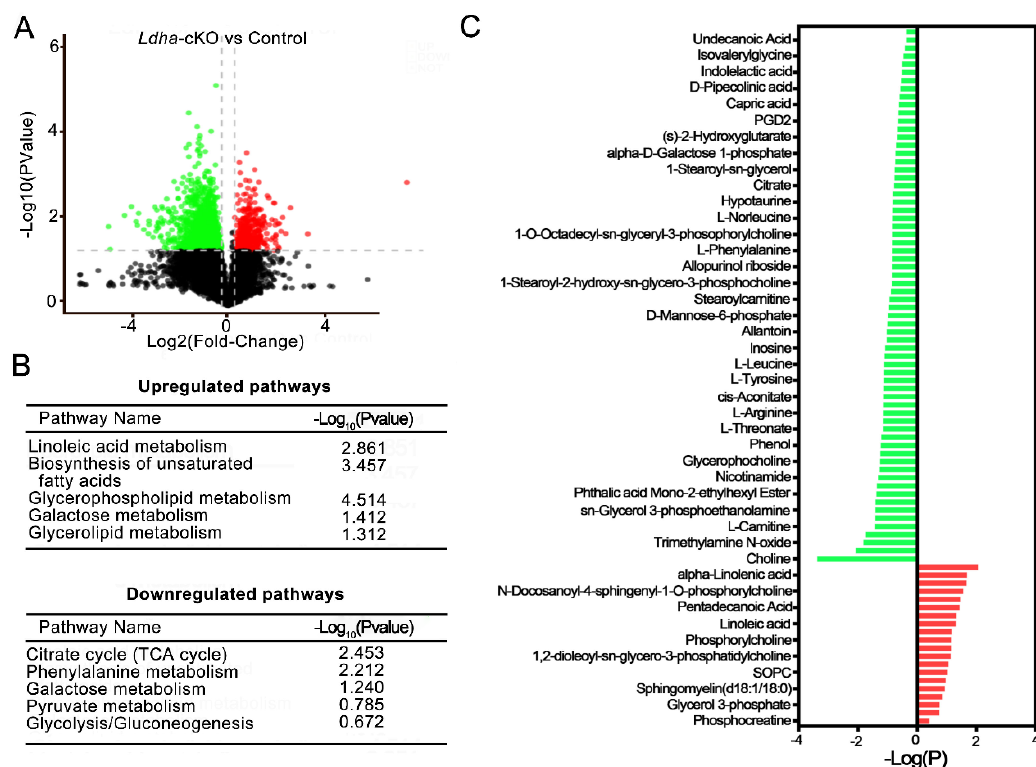
Figure 5. Metabolomic dysregulations in sperm from Ldha -cKO compared to control male mice. ( A ) The volcano plot displays the upregulated (red dots) and downregulated (green dots) metabolites. ( B ) Overview of up － and downregulated pathways in Ldha -cKO mouse sperm. ( C ) Overview of up- and downregulated metabolites of sperm in the male control (n = 6) and Ldha -cKO mice (n = 7).